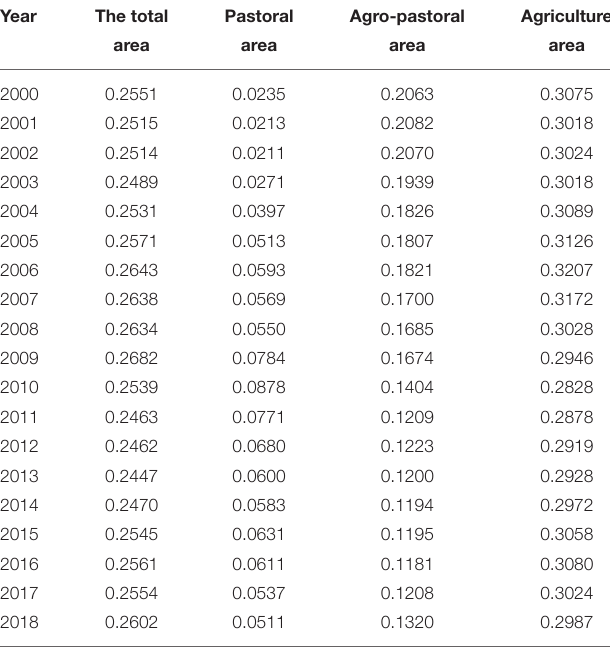
TABLE 3 | Theil index of carbon emissions of animal